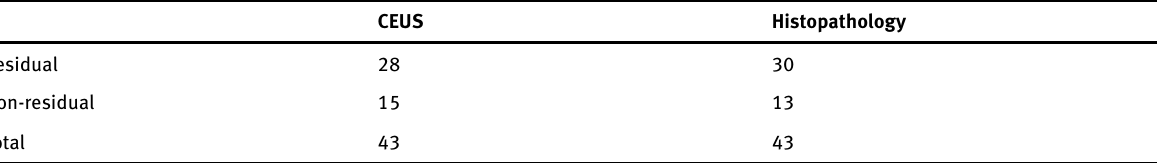
Table 4 . Comparison of the judgment of ablation lesion completeness between contrast-enhanced ultrasound (CEUS) and histopathology. CEUS